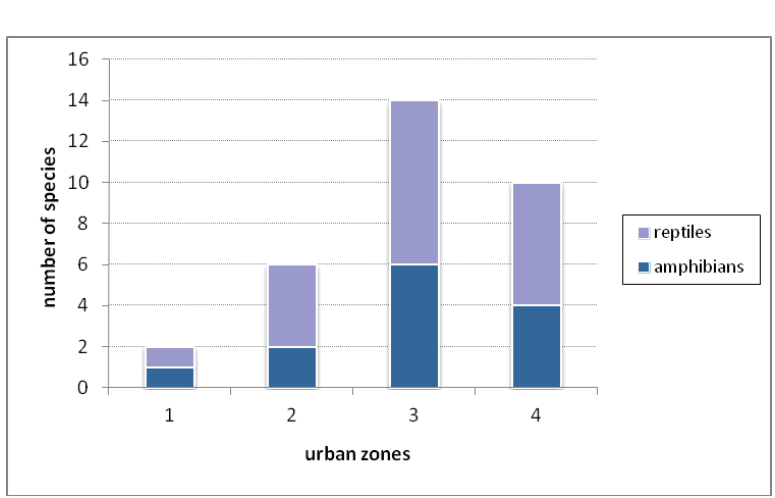
Figure 2. Number of species in the urban